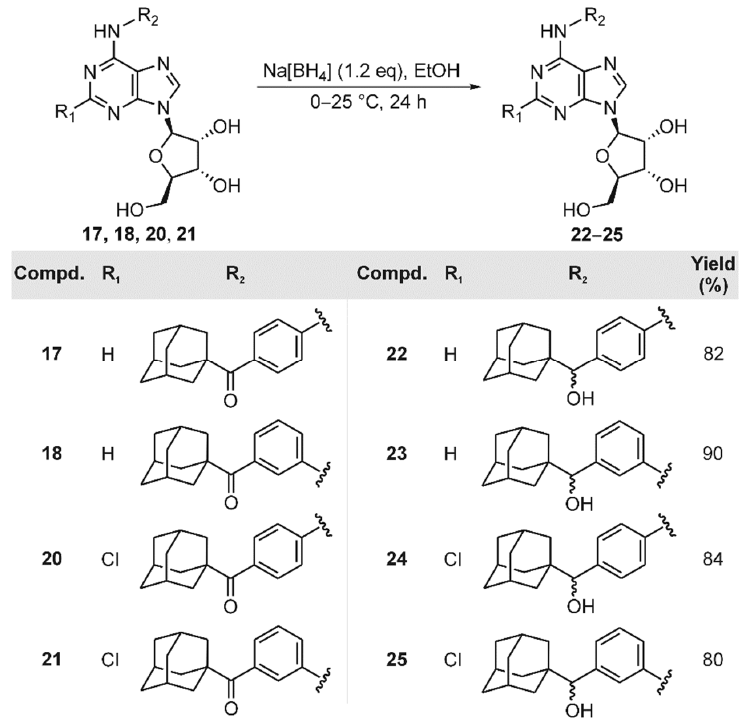
Figure 3. An X-ray diffraction analysis of purine 13. An ORTEP diagram was drawn with a 40% ellipsoid probability